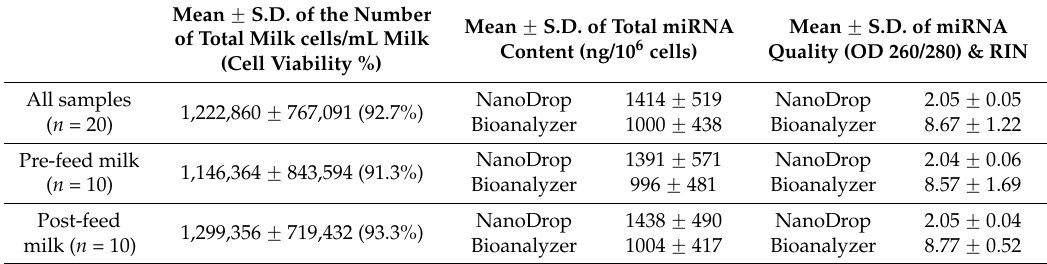
Table 3. The mean ˘ standard deviation of HM cell content, and miRNA content and quality using NanoDrop 2000 and Bioanalyzer 2100 respectively, in pre-feed and post-feed milk samples ( n = 10